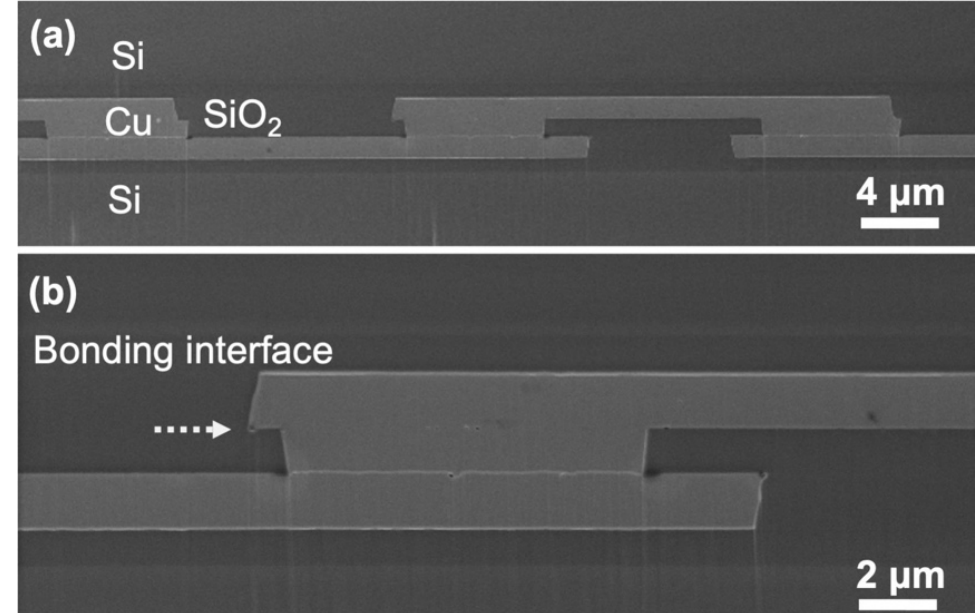
Figure 6. ( a ) SEM and ( b ) enlarged SEM images showing a row of Cu-Cu joints surrounded by SiO 2 dielectrics. SiO 2